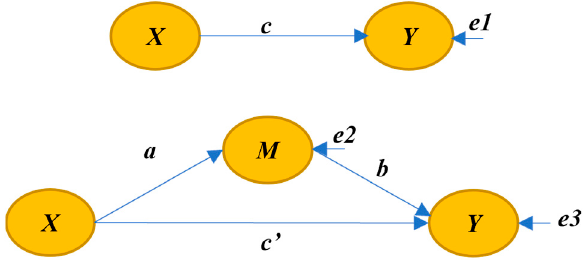
Figure 4. Schematic diagram of intermediary effect.